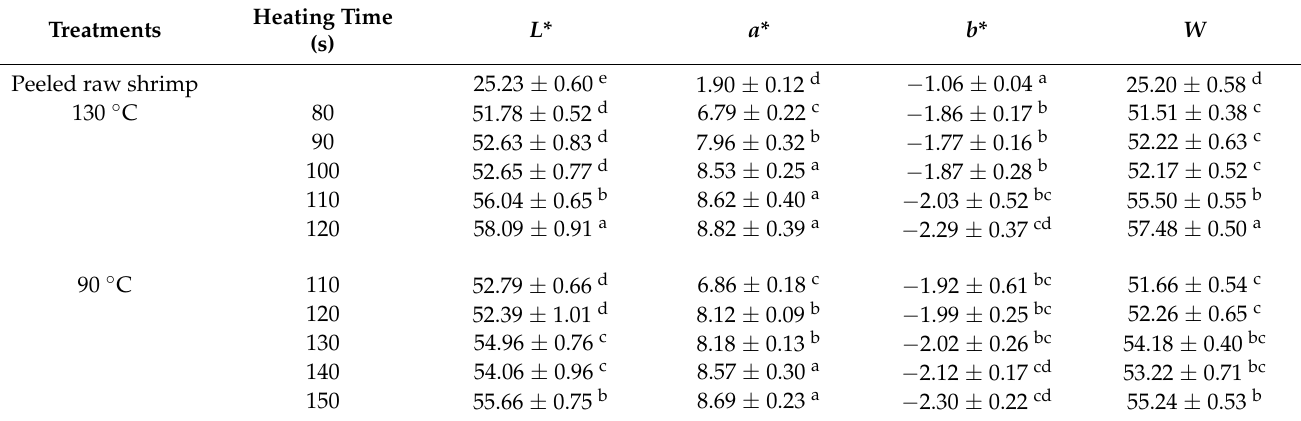
Table 3. Values of color ( L *, a *, b *, W ) in peeled white shrimp using the scaled-up MAIH system set at 130 ◦ C and 90 ◦ C for various heating